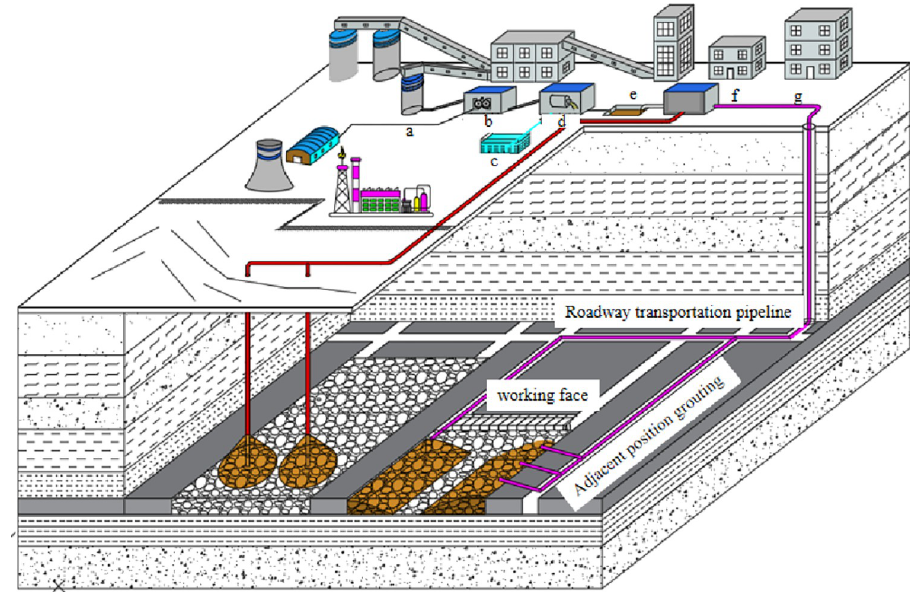
Fig 1. Pipe filling of gangue slurry in goaf. a-Gangue bin, b-Crushing station, c-Reservoir, d-Grinding station, e- Collecting tank, f-pumping station, g-Transmission pipeline.